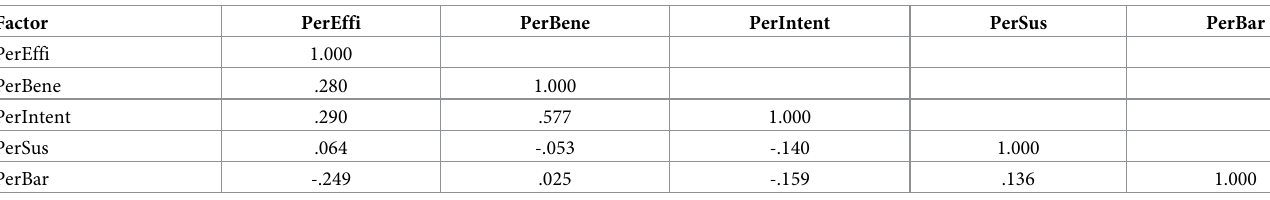
Table 2. Factor correlation matrix of the final EFA model. Factor PerEffi PerBene PerIntent PerSus PerBar